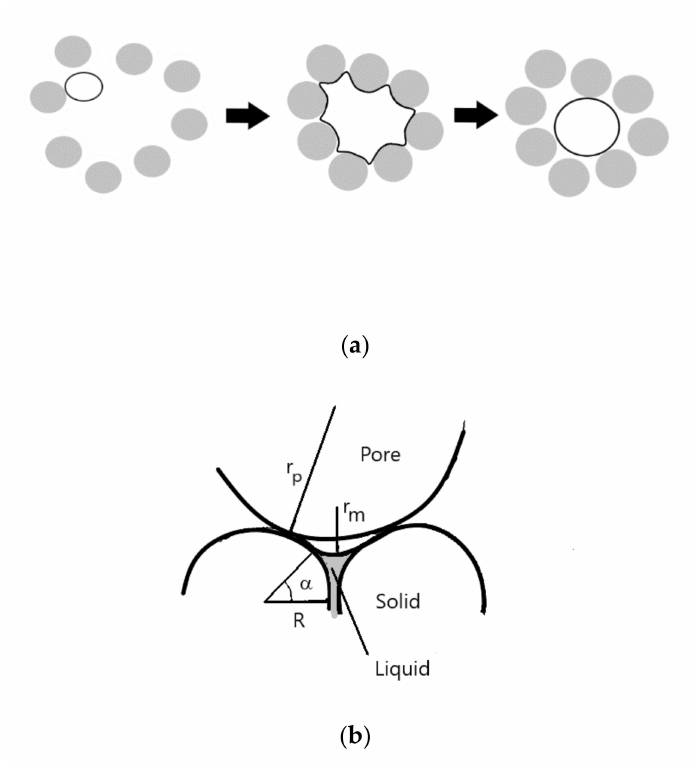
Figure 3. Illustration of the pore formation and profiling mechanisms: ( a ) Pore formation sequence with nucleation, precipitation and compression as well as the final stage of partial filling, and ( b ) Geometries illustrating conditions for pore filling, freely after